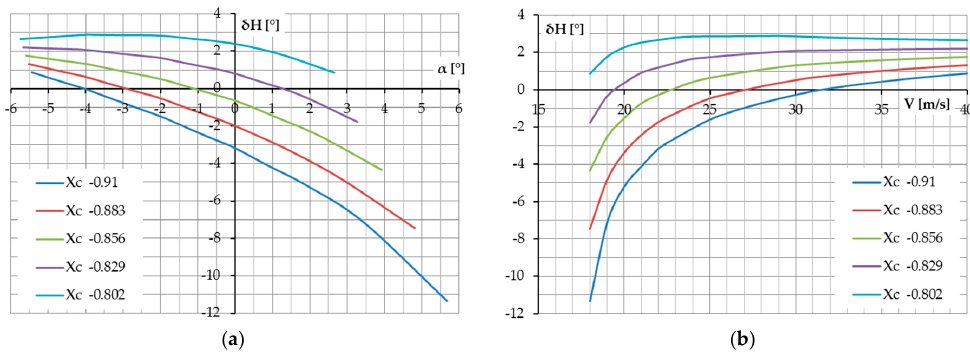
Figure 13. Elevator deflection required to trim the airplane in steady level powered flight: ( a ) with respect to the angle of attack; and ( b ) with respect to the airspeed. respect to the angle of attack; and ( b ) with respect to the